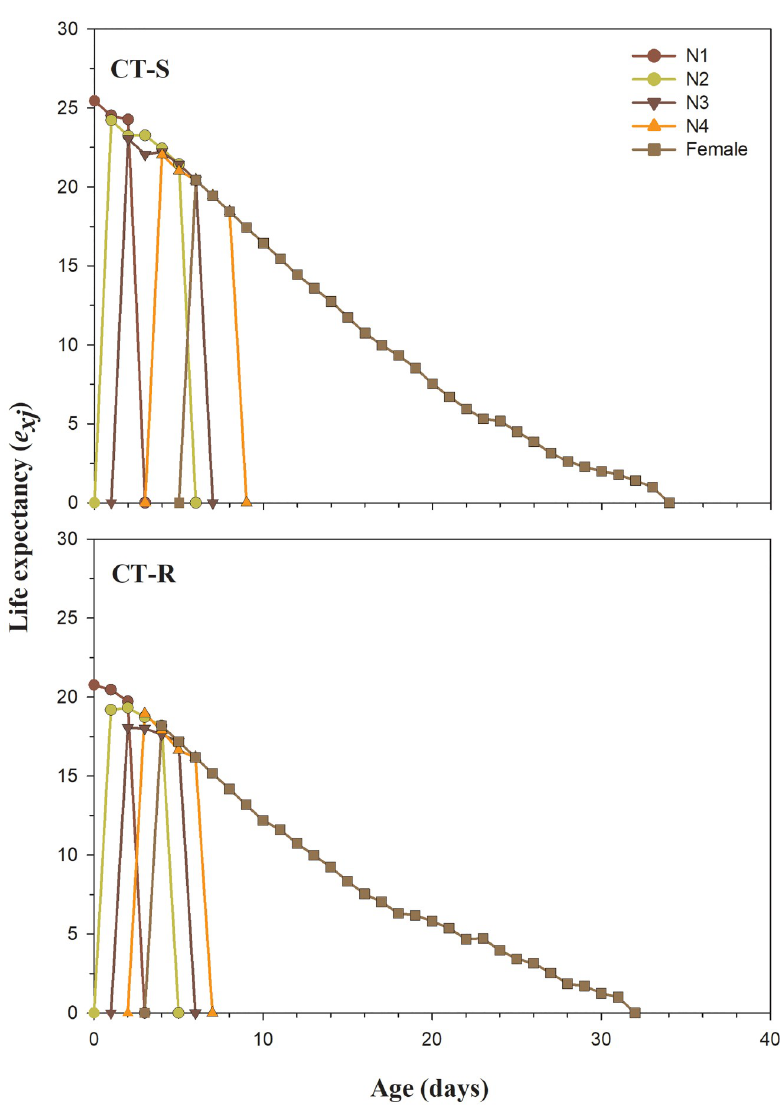
Fig 3. Age-stage specific life expectancy ( e